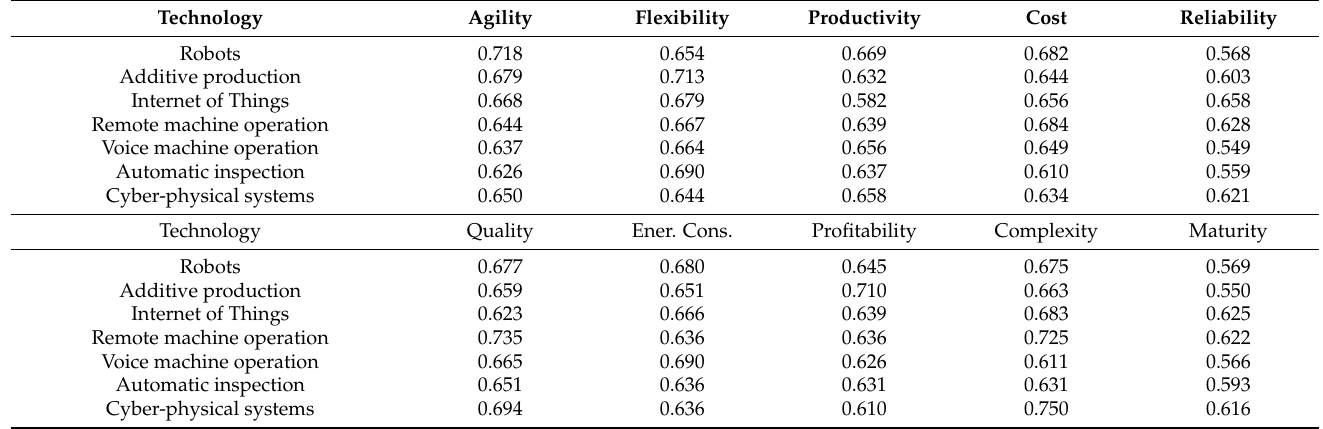
Table A5. The defuzzied weighted arithmetic sequence.